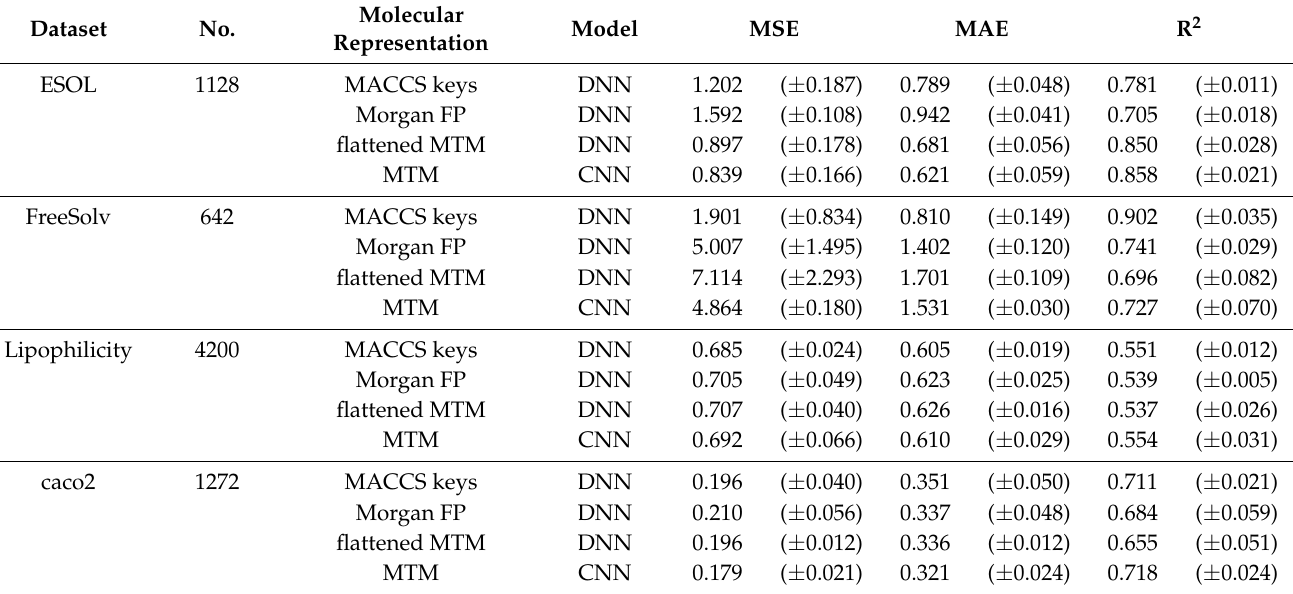
Table 2. Performance comparison of the four datasets for four models.